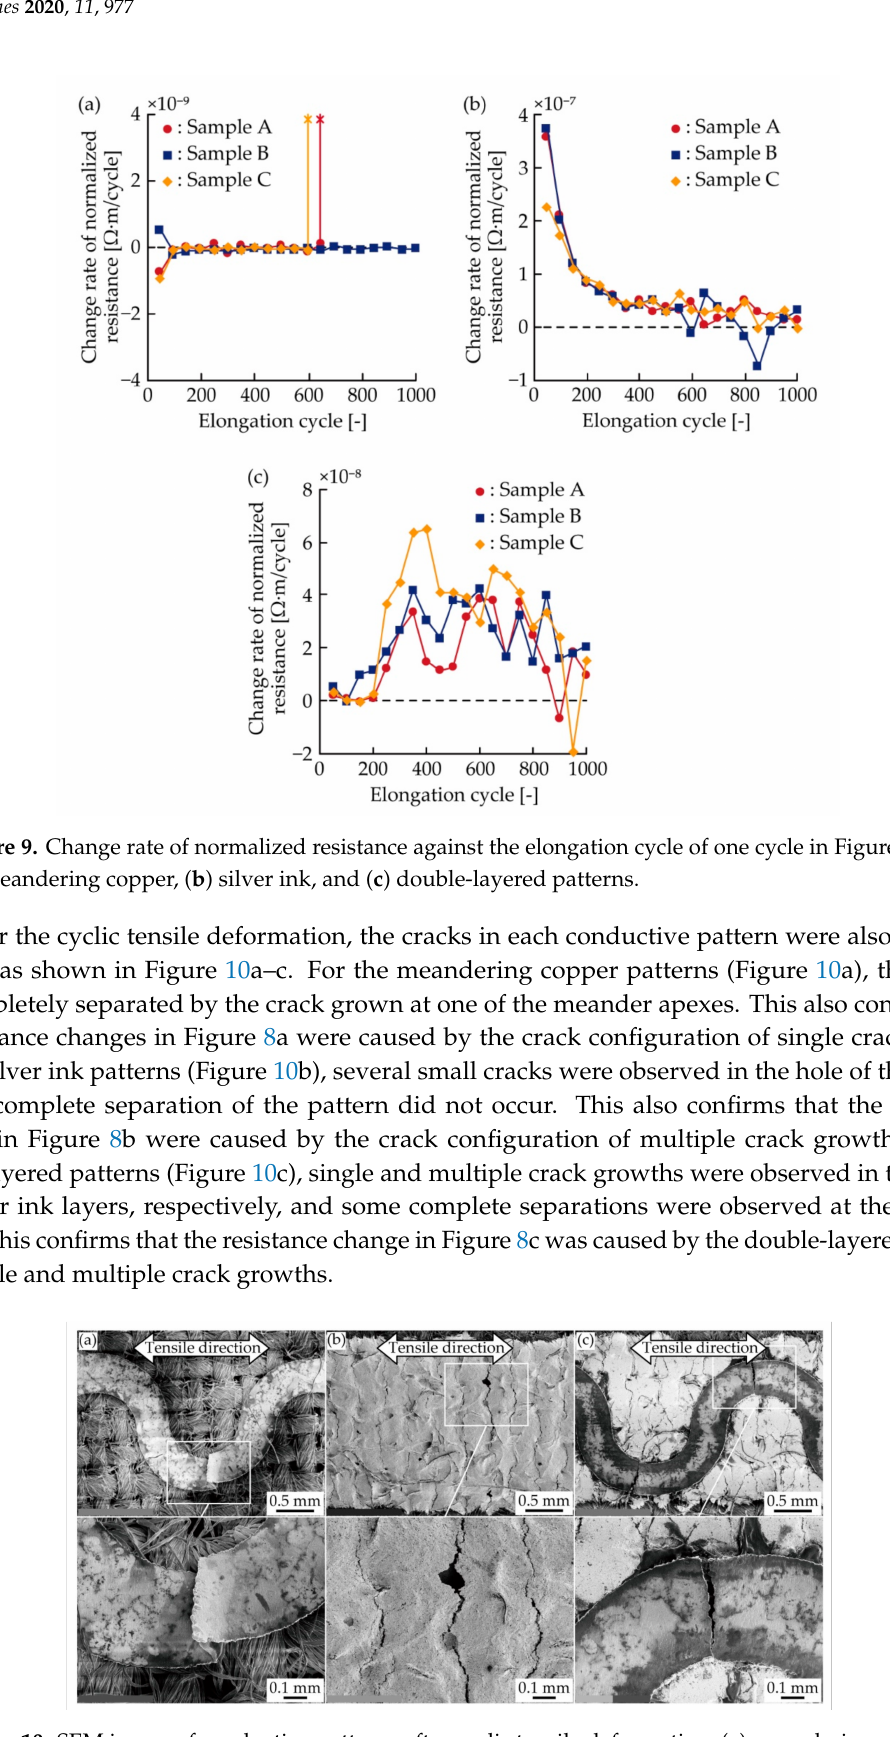
Figure 10. SEM image of conductive patterns after cyclic tensile deformation; ( a ) meandering copper, ( b ) silver ink; and ( c ) double-layered